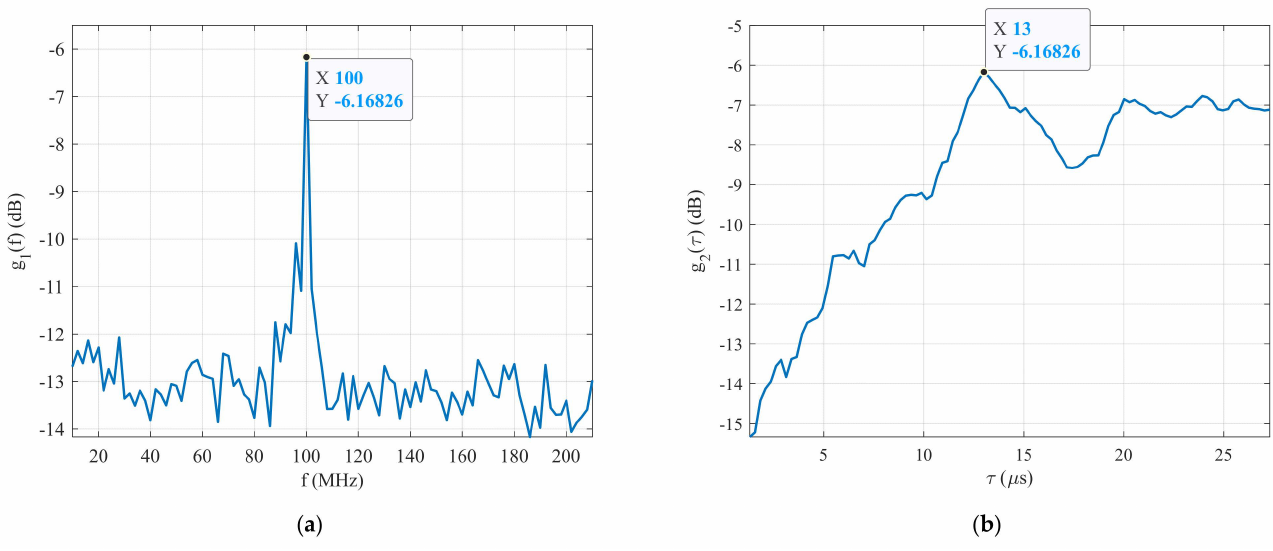
Figure 14. The simulation results: ( a ) detection process, and ( b ) pulse width